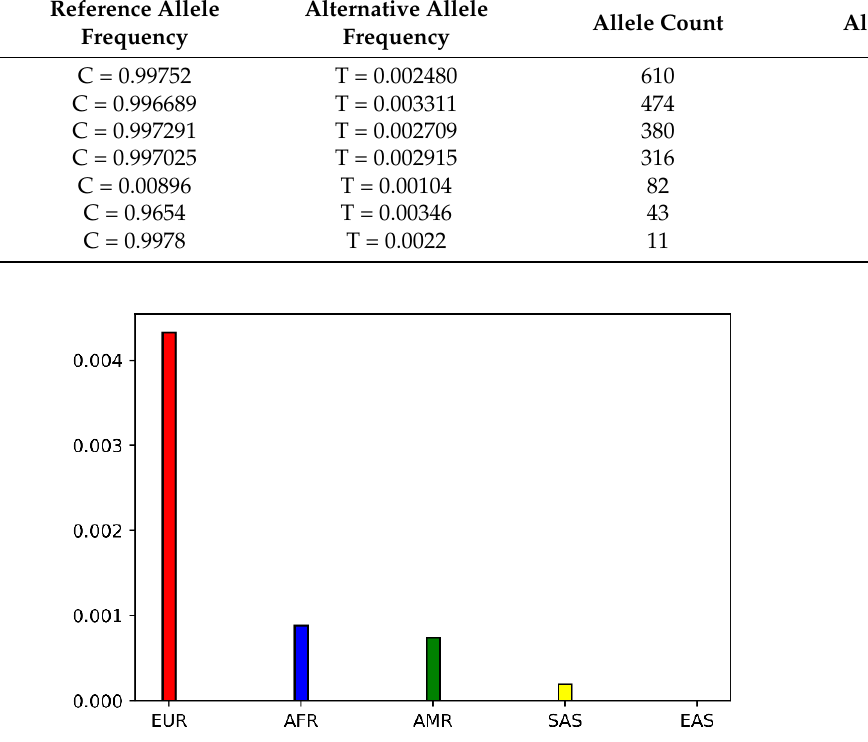
Figure 2. Population distribution of POR variant P228L extracted from GnomAD database (variant ID: 7-75610876-C-T). P228L appears to be a rare variant mainly found in Europeans (EUR). The